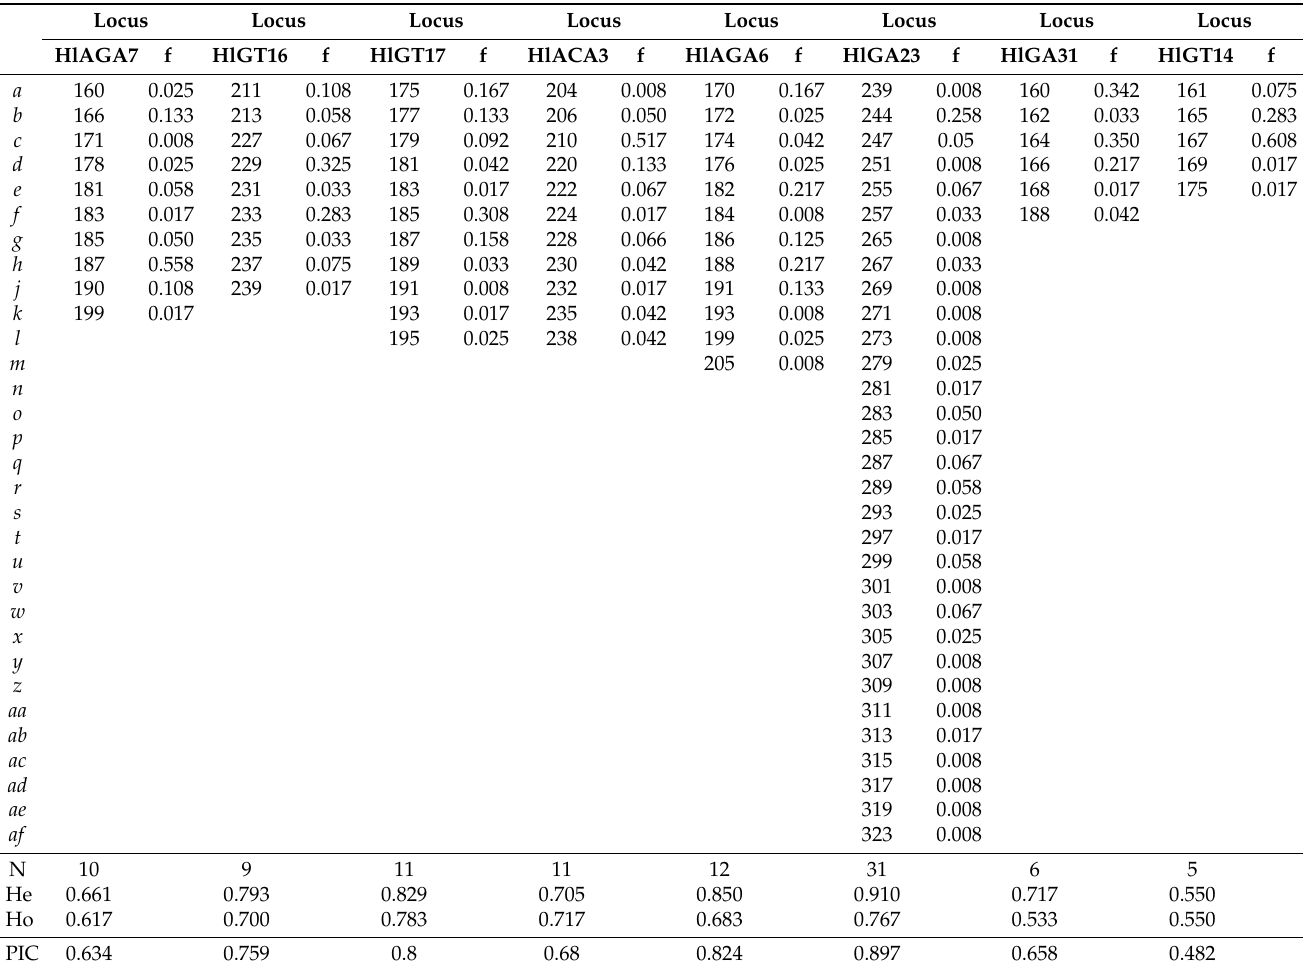
Table 3. Allele size (bp), allele frequency (f), number of alleles (N), Observed (Ho) and Expected Heterozygosity (He) and Polymorphism Information Content (PIC) of the studies